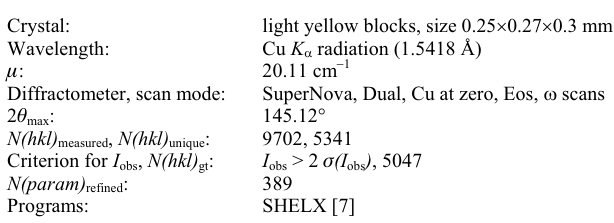
Table 2. Atomic coordinates and displacement parameters (in Å 2 )